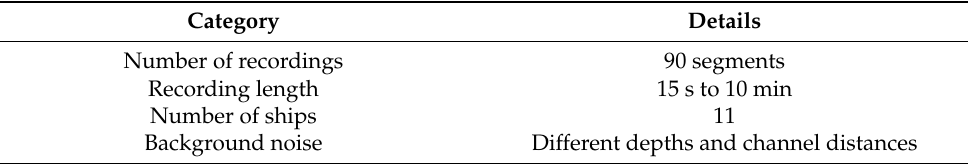
Table 2. The composition of the database.